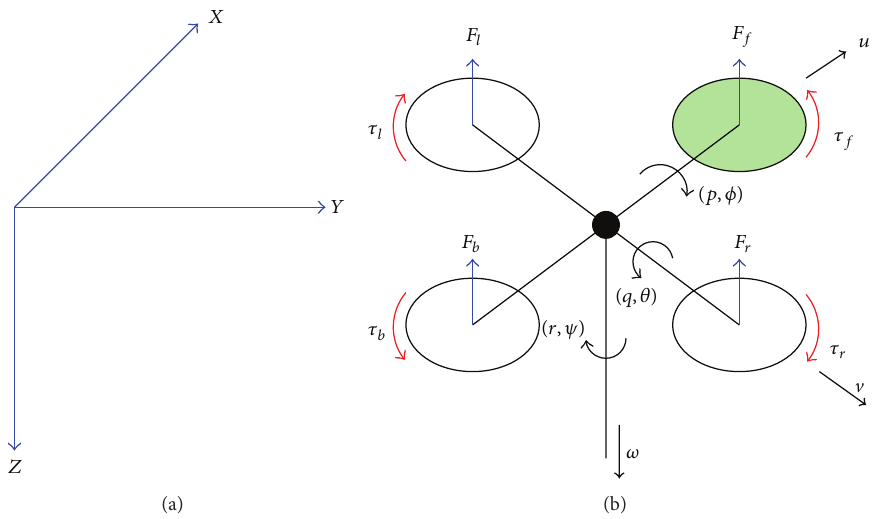
Figure 1: Inertial frame (a) and forces and torques acting on the quadrotor (b).